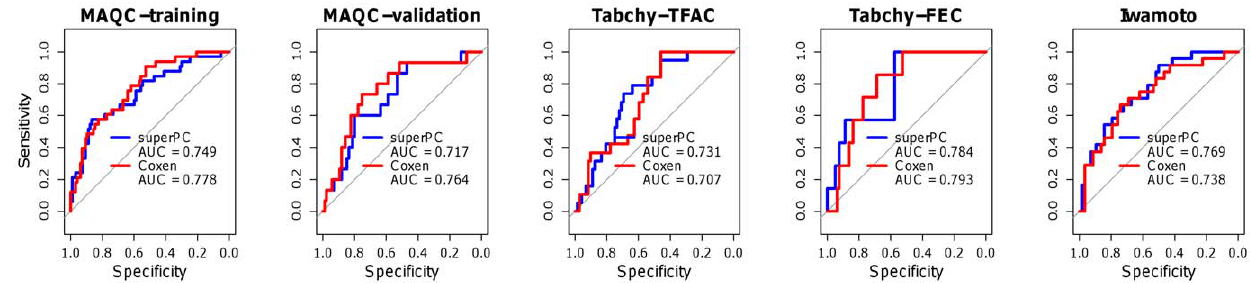
Figure 4. ROC curve validation of MGPs from the Neve training set in 5 clinical trials. In each figure, blue lines represent MGPs developed using the superPC method, while red lines represent MGPs developed using the COXEN method.